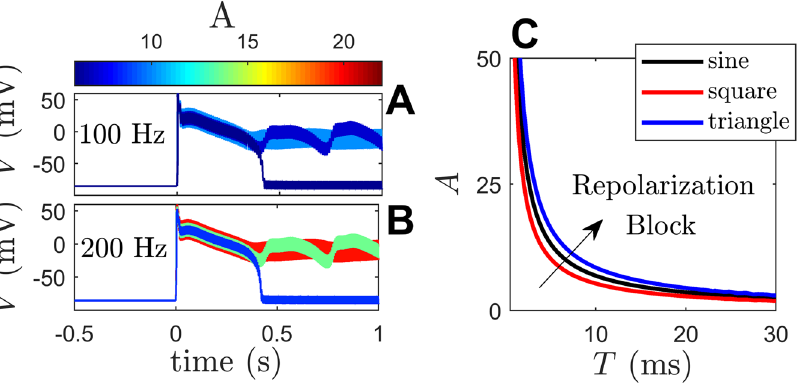
Figure 4. Panels A and B illustrate model behavior under the application of sinusoidal stimulation of various amplitudes and periods. In panel C, stimulation parameters to the right of the solid lines will produce repolarization block.